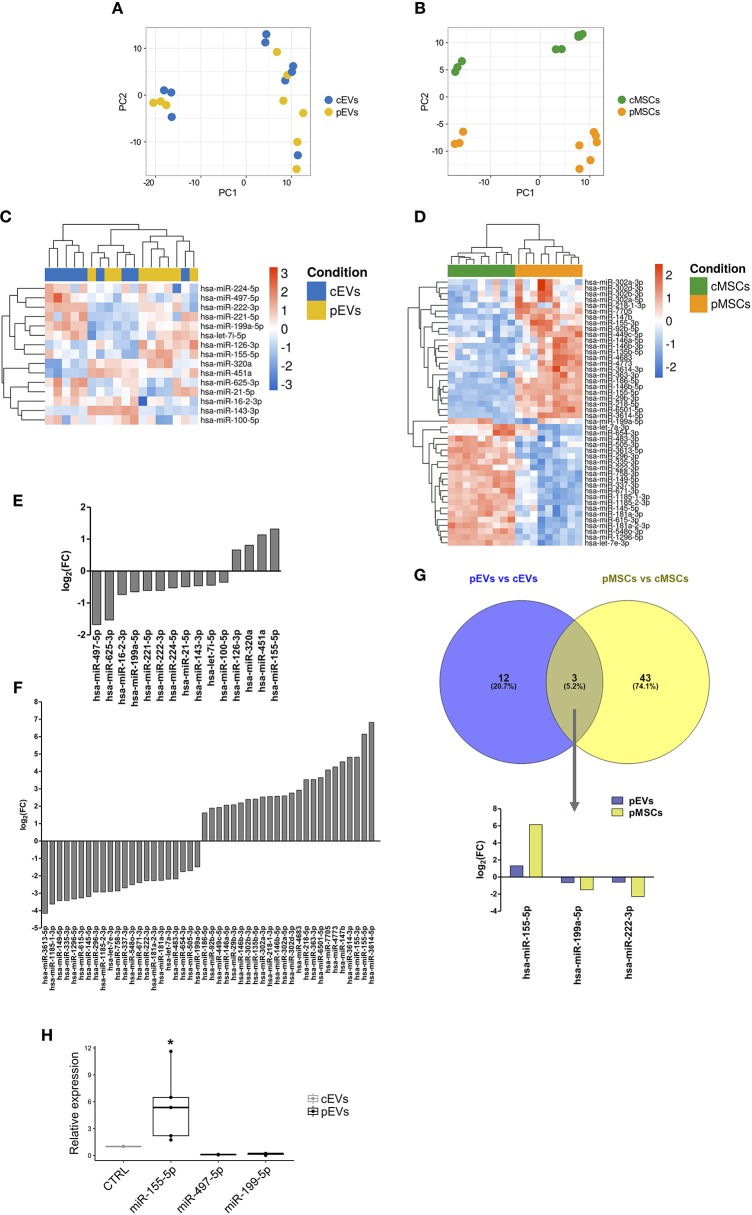
miRNA expression profile of MSCs and EVs following inflammatory priming. PCA plot calculated using regularized-logarithm transformation of miRNA counts on EVs (A) and MSCs (B) samples. Heatmap summarizing differentially expressed miRNAs in pEVs (C) and pMSCs (D). Bar plot representing the log2-fold change of differentially expressed miRNAs in pEVs (E) and pMSCs (F). (G) Venn diagram representing common differentially expressed miRNAs in pEVs and pMSCs. (H) RT-qPCR validation of differentially expressed miRNA in pEVs (n ≥ 3). Wilcoxon test *p < 0.05.